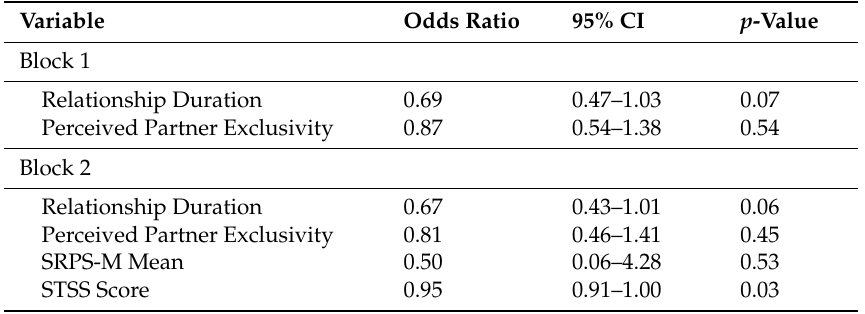
Table 5. Logistic Regression Analysis for Variables Predicting Condom Use at Last